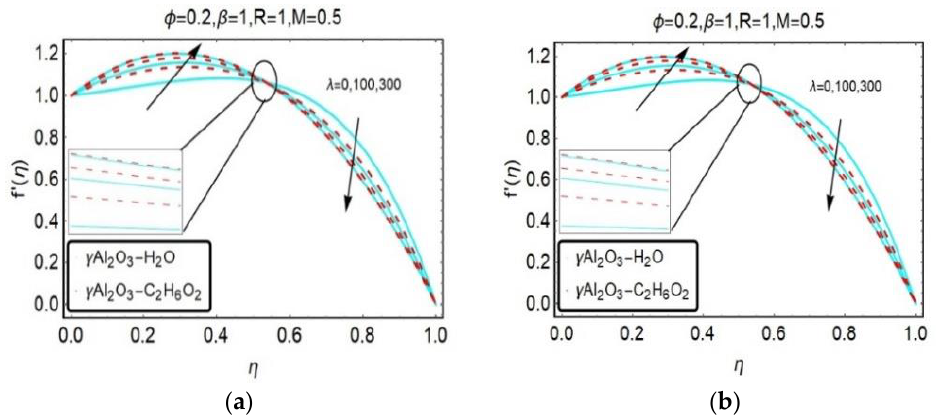
Figure 9. Influence of 𝑀 2 on 𝑓′(𝜂) for ( a ) 𝑆 > 0 and ( b ) 𝑆 < 0 .